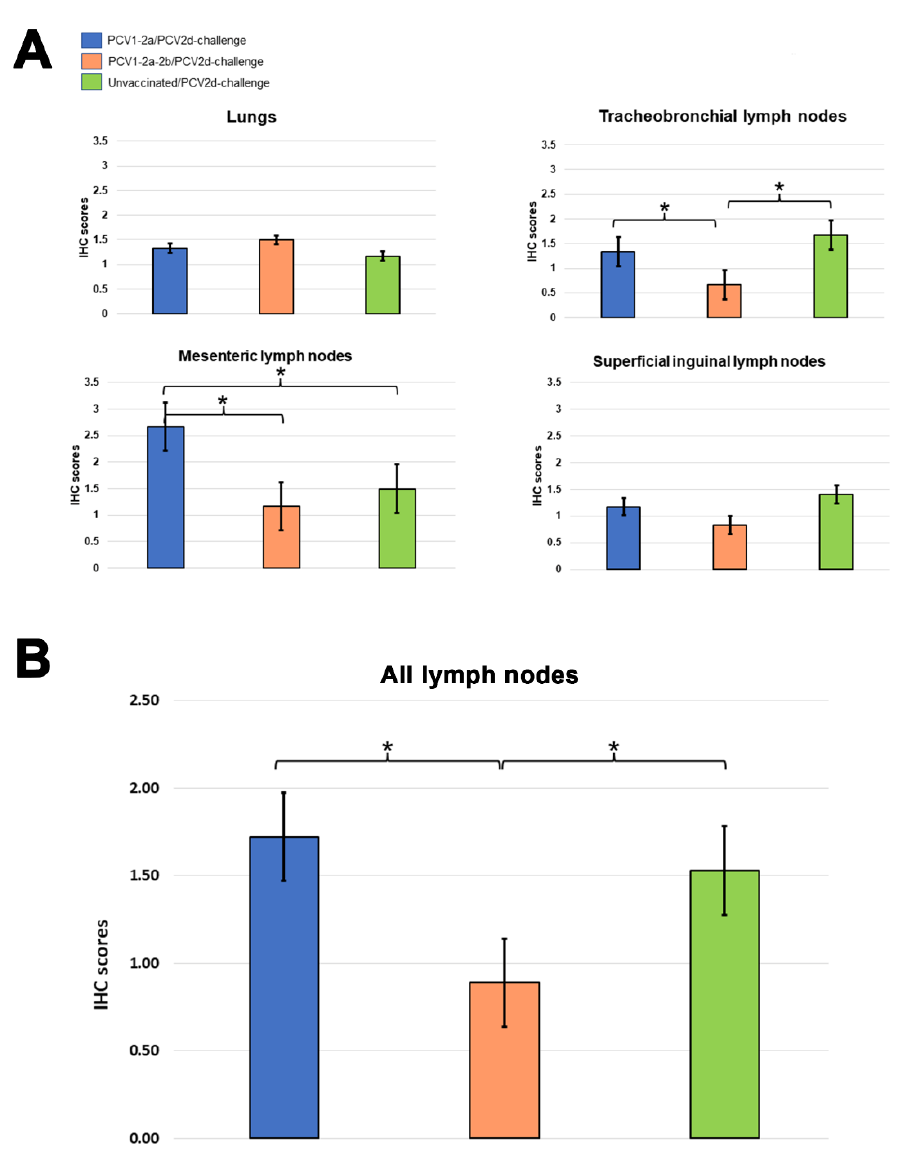
Figure 2. PCV2-positive immunohistochemical scoring of the lungs, tracheobronchial lymph nodes, mesenteric lymph nodes, and superficial inguinal lymph nodes of pigs. There were significant differences between the IHC scores of PCV1-2a-2b/PCV2d-challenge and unvaccinated/PCV2d-challenge pigs in the tracheobronchial lymph nodes ( A ). However, the average IHC immunolabelling-positive scores of all lymph nodes in each group were significantly different in comparisons made between the PCV1-2a-2b/PCV2d-challenge group and the PCV1-2a/PCV2d-challenge or unvaccinated/PCV2d- challenge groups ( B ). Data presented as values of mean ± standard error. Asterisks indicate statisti- cally significant differences (* p <